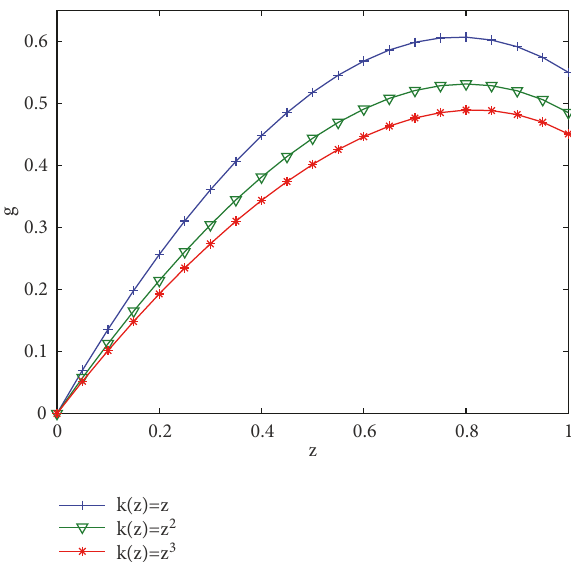
Figure 3: Flux distribution for 𝑘(𝑧) = 𝑧, ℎ(𝑧) = 1 − 𝑧, 𝑛 = 0.5, 𝛼 = 0.1, 0.5, 1.0, 2.0.